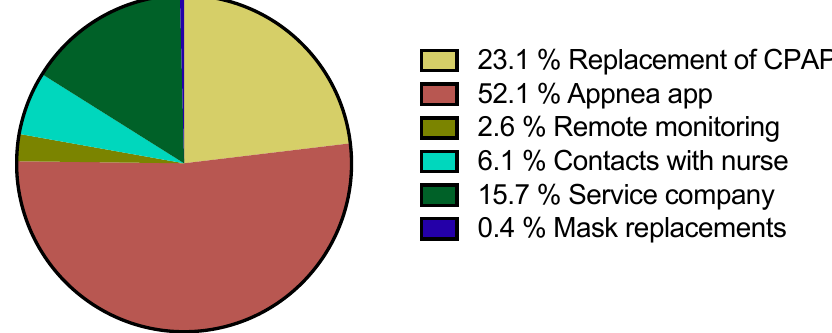
Figure 5. Cost distribution of the proposed telemedicine intervention.